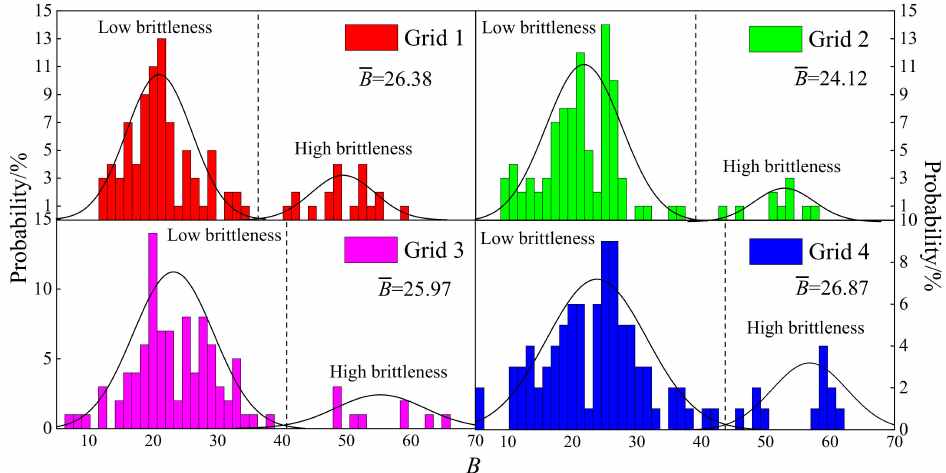
Figure 11. Frequency index B